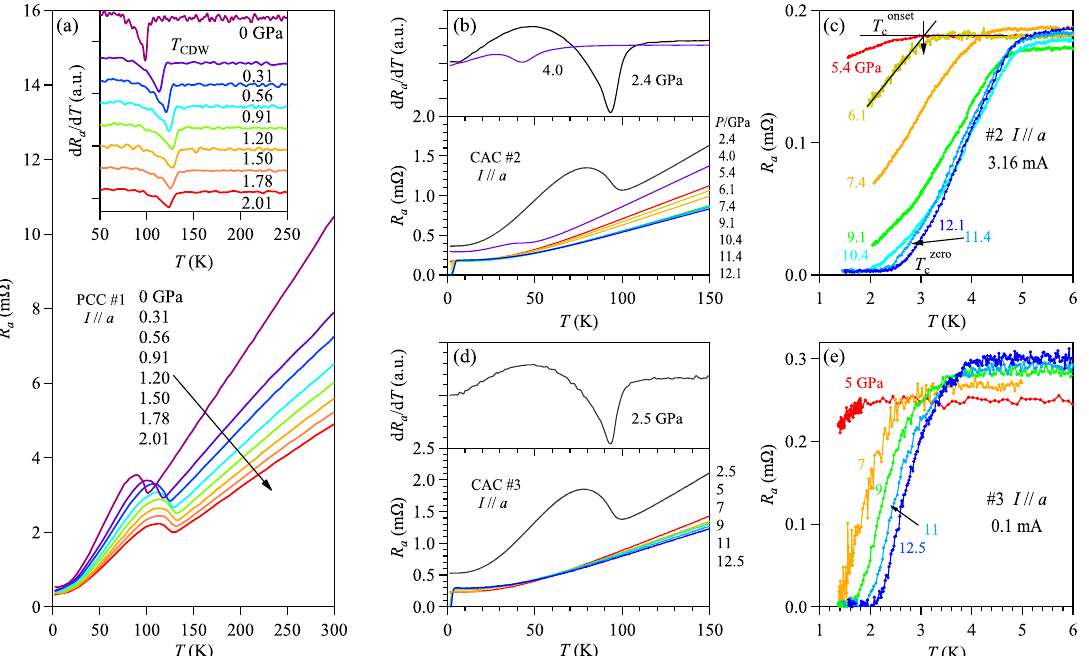
Fig. 3 The a -axis resistance under high pressure. a Temperature dependence of the a -axis resistance R a ( T ) for sample #1 under various pressures up to 2.01 GPa measured with a piston-cylinder cell (PCC); the inset shows the d R a /d T of the data in ( a ) to determine the charge- density-wave transition temperature T CDW . b R a ( T ) for sample #2 under various pressures from 2.4 to 12.1 GPa measured with a palm cubic anvil cell (CAC); the upper panel shows the d R a /d T curves at 2.4 and 4.0 GPa to determine the values of T CDW . c The low-temperature R a ( T ) for sample #2 under various pressure from 5.4 to 12.1 GPa. d R a ( T ) for sample #3 under various pressures from 2.5 to 12.5 GPa; the upper panel shows the d R a /d T curve at 2.5 GPa to determine the values of T CDW . e The low-temperature R a ( T ) for sample #3 under various pressure from 5 to 12.5 GPa highlighting the evolution of the possible superconducting